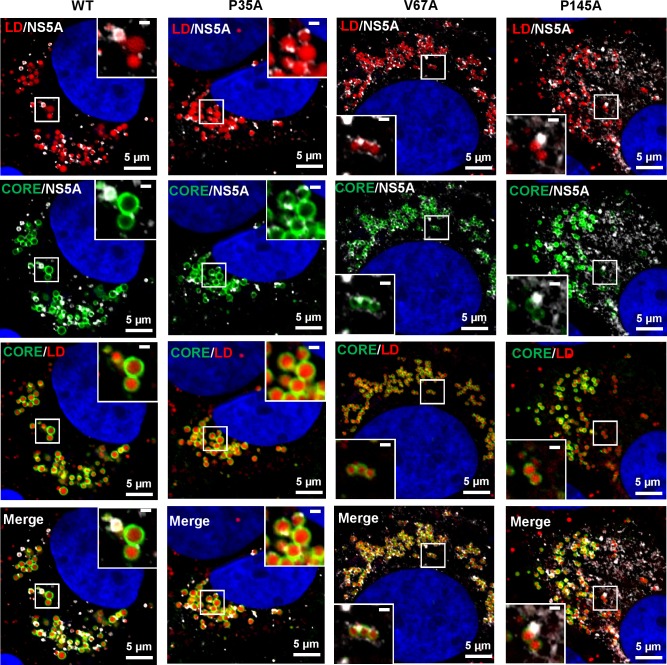
Subcellular distribution of Core and NS5A relative to the LDs in infected cells is disrupted by domain I mutations V67A and P145A.Spatial distribution of Core and NS5A relative to the LD in Huh7.5 cells electroporated with in vitro transcripts of either wild-type mJFH-1, or NS5A mutants P35A, V67A and P145A. Cells were seeded onto coverslips and incubated for 72 h.p.e. prior to fixation and immunostaining for Core (rabbit, 1:500), NS5A (sheep, 1:2000) and LD (BODIPY 558/568-C12, 1:1000), and imaging by Airyscan microscopy. The scale bars are 5μm and 0.5 μm, respectively.